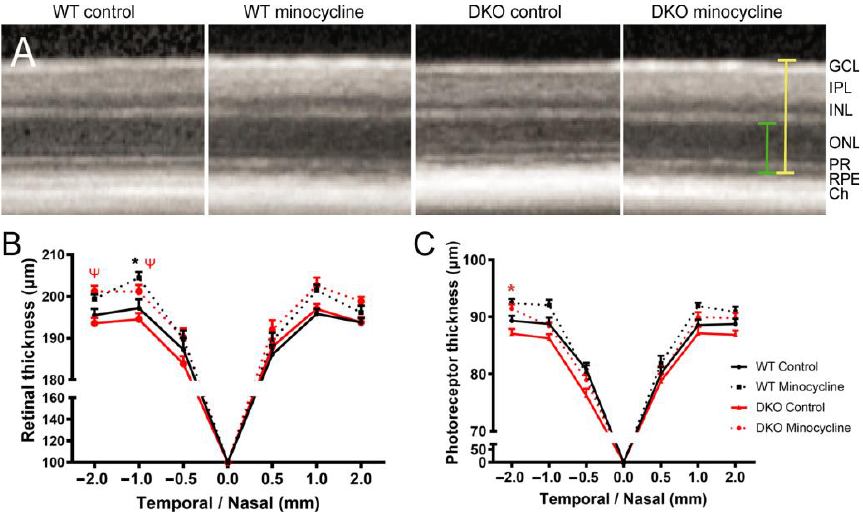
Figure 4. The effect of minocycline on retinal thickness. ( A ) Representative SD-OCT images from vehicle- or minocycline-treated wild type (WT) and double knockout (DKO) mice. Yellow line showing the measurement of the overall retinal neuronal thickness, the green line showing the measurement of outer retina (photoreceptor layer, including ONL and PR) thickness. ( B , C ) Graphs showing the overall retinal neuronal thickness ( B ) and photoreceptor layer thickness ( C ) at the positions of 0.5, 1 and 2 mm away from the optic disc at temporal and nasal sites. Mean ± SEM, n ≥ 8 mice (16 eyes), * p < 0.05 between minocycline-treated and vehicle-treated WT mice at the same location, ψ p < 0.05 between minocycline-treated and vehicle-treated DKO mice at the same location. 2-way ANOVA with Sidak’s multiple comparison test. GCL: ganglion cell layer; IPL: inner plexiform layer; INL: inner nuclear layer; ONL: outer nuclear layer; PR: photoreceptor segments; RPE: retinal pigment epithelia; Ch: choroid; WT: Wild type; DKO: double